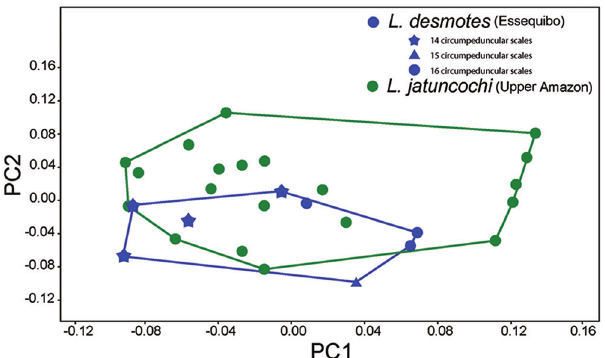
Fig. 4. Scatterplot of principal component 1 (PC1) versus principal component 2 (PC2) for the analysis containing only Leporinus desmotes (blue), and L. jatuncochi (green). Leporinus desmotes symbols exhibit variation in circumpeduncular scale counts. Stars are specimens with 14 circumpeduncular scales, circles are specimens with 16 circumpeduncular scales, and the triangle represents the specimen with 15 circumpeduncular